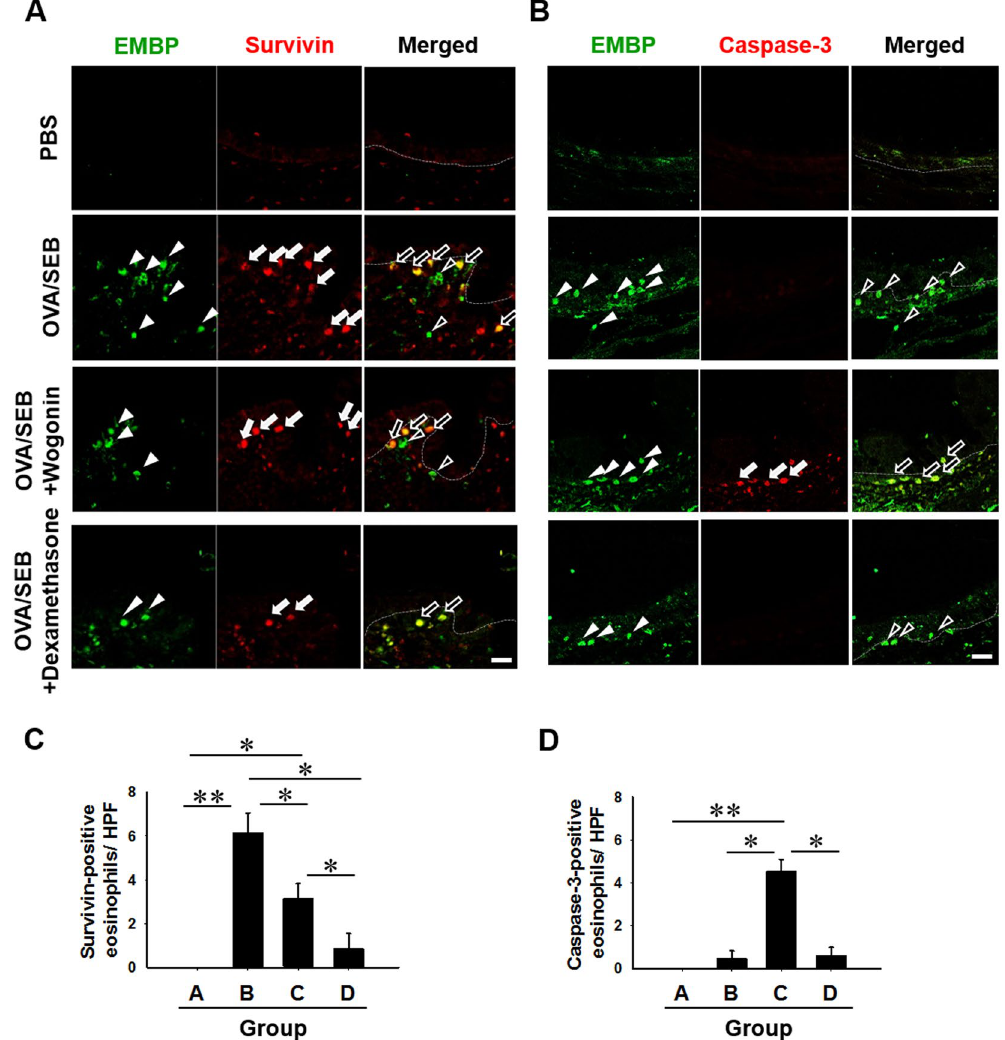
Figure 6. Fluorescence micrographs of EMBP, survivin, and caspase-3 positive cells in the mouse polyp model. ( A ) Representative photographs of survivin-positive and ( B ) caspase-3-positive eosinophils. ( C) and ( D ) Quantitative analysis of survivin and caspase-3 -positive eosinophils. Dotted lines represent the border between respiratory epithelium and submucosa. Arrowheads denote EMBP-positive cells in each group of mice. White arrows denote survivin-positive cells in A and caspase-3-positive cells in B. Data are expressed as the mean ± SD. * P < 0.05, ** P < 0.01. Mann-Whitney U test. Scale bar = 10 μ